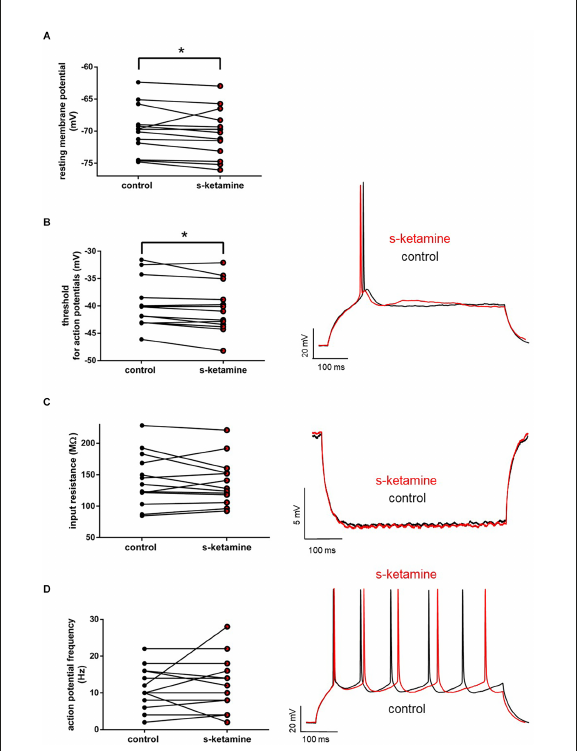
FIGURE2 (A) s-ketamine marginally ( < 0.6 mV) but significantly (*) ( p = 0.027) shifted the resting membrane potential